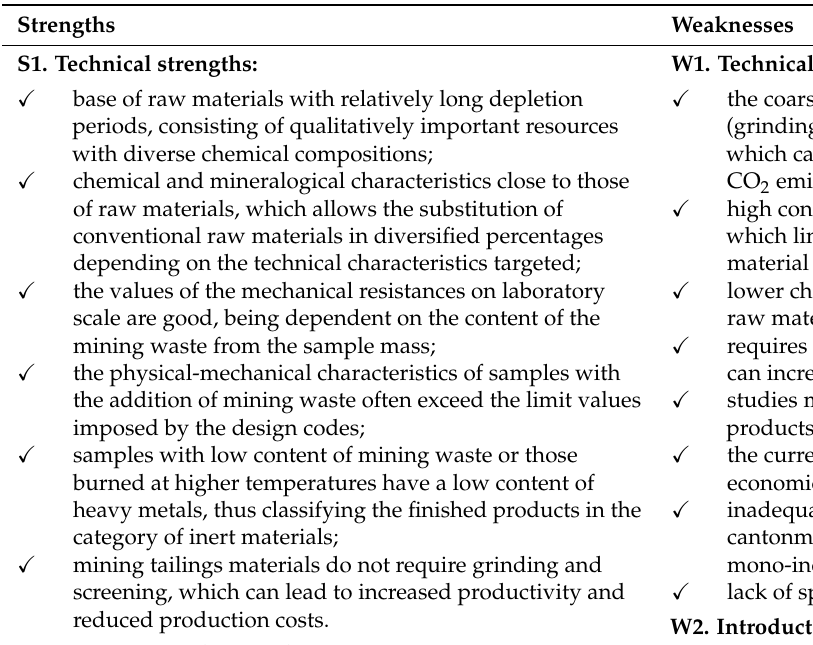
Table 5. Strengths–Weaknesses–Opportunities–Threats (SWOT)